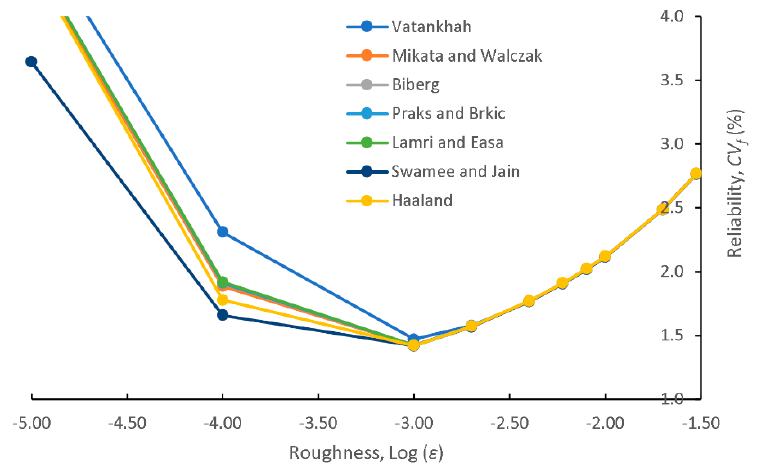
Figure 3. Variation of the reliability of various approximations as roughness varies ( ν = 1x10 − 6 , CV ε = 0, CV ν = 30%).